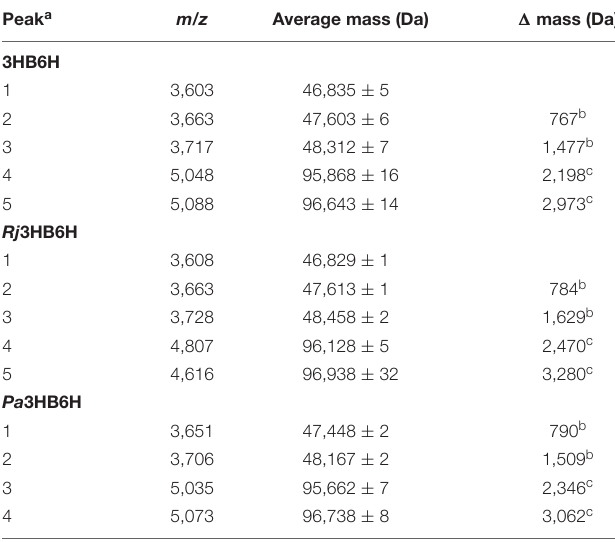
TABLE 5 | Oligomeric forms of 3HB6H determined by native ESI-MS. Peak